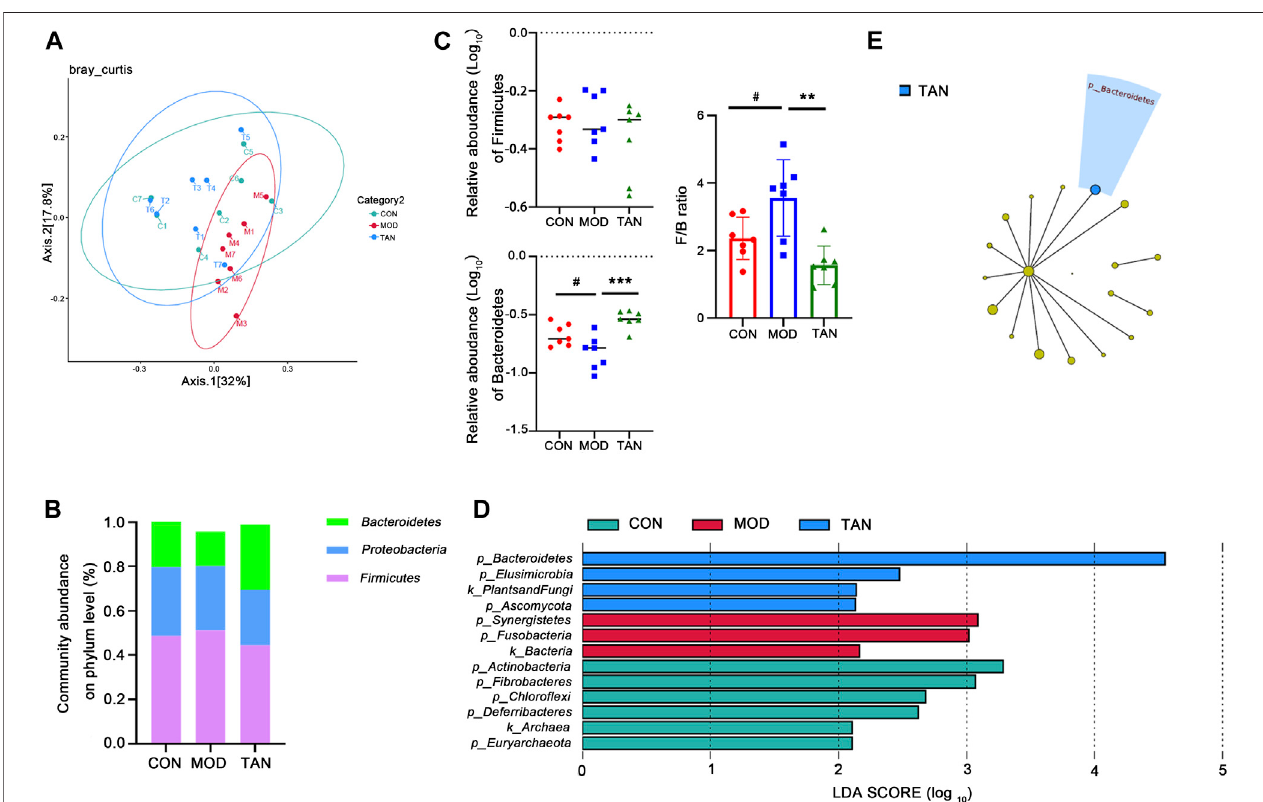
FIGURE 4 | TAN restored the impaired diversity of the gut microbiome and regulated the gut microbiome at the phylum level ( n = 7 rats in each group). (A) The β - diversity analysed by PCoA suggested thatthe distribution ofthe dots in the MOD group wasdistinguished from thatin the CON group, whereas most ofthe samples in the TAN group were distributed similarly as in the CON group. (B) The relative abundance of the three top-ranked phyla among the three groups. (C) The relative abundance (log10) of Firmicutes and Bacteroidetes and their ratio compared among the three groups. The difference between the groups was assessed by one- wayanalysisofvariance. # p < 0.05vs . CONgroupand** p < 0.01,*** p < 0.001vs . MODgroup. (D) FeaturephylaintheCON,MOD,andTANgroupsattheLDA2levelas analysedbyLEfSe. (E) FeaturephylaintheTANgroupattheLDA4 levelasanalysedbyLEfSe.TAN,tanshinoneIIA;CON,control;MOD, model;LDA,lineardiscriminant analysis; LEfSe, LDA effect